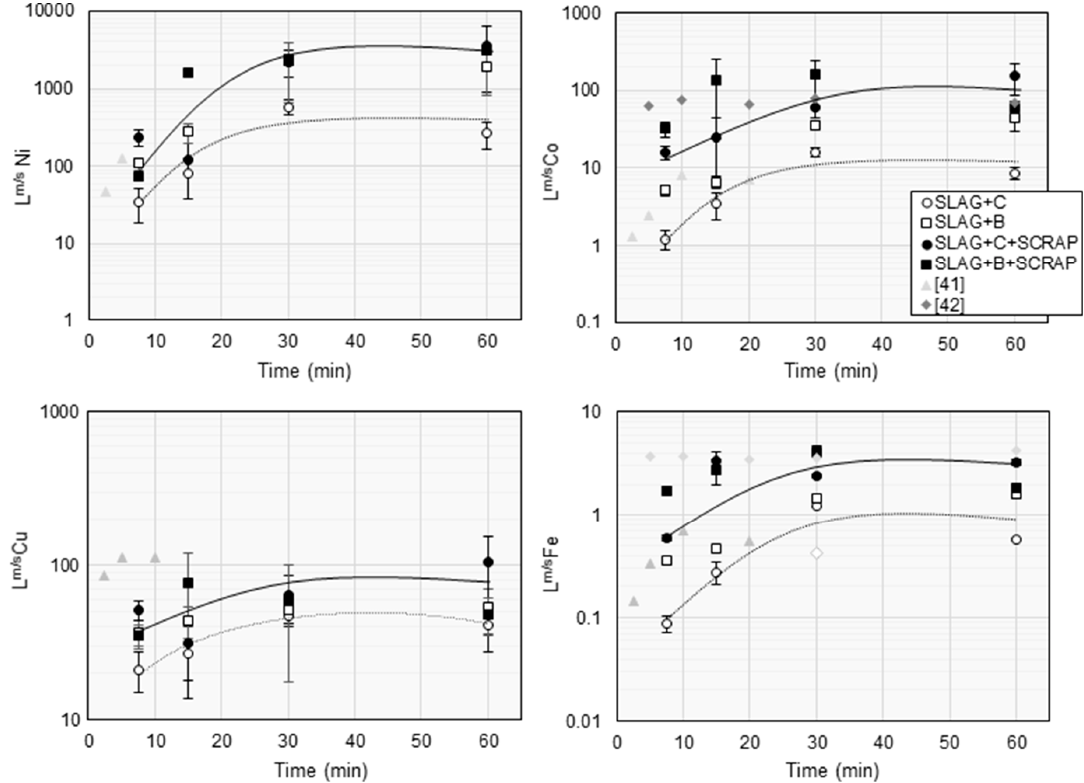
Figure 6. Matte-slag distribution coefficients of nickel, cobalt, copper and iron as a function on reduction time at 1400 °C. Trend lines were drawn for coke-containing reduction experiments: SLAG + C as dotted black line ( ∙∙∙ ) and SLAG + C + SCRAP as solid black line ( ‒ ).